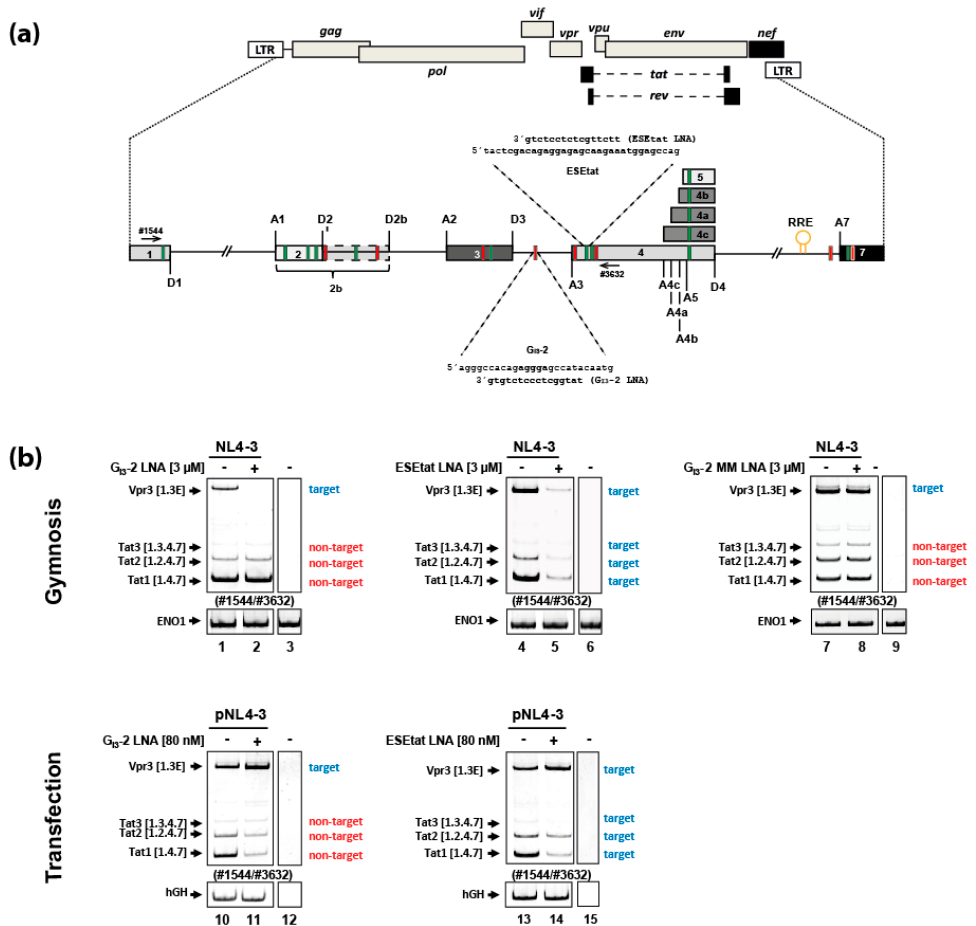
Figure 1. Gymnotically-delivered LNA mixmers targeting viral splicing regulatory elements (SREs) induce degradation of viral mRNAs containing their target sequence. ( a ) The diagram illustrates the HIV-1 proviral genome including open reading frames (ORFs) of viral proteins, long terminal repeats (LTRs), viral splice donor (D) and acceptor (A) sites as well as the viral splicing regulatory elements (enhancing SREs: Green, silencing SREs: Red). The Rev responsive element (RRE) for the Rev-dependent export of the intron-containing viral mRNA species is indicated by an open circle within the last HIV-1 intron. The primer binding sites (#1544, #3632; see Figure 1a) are also shown. The sequences as well as their target sequences of the G I3 -2 and ESE tat LNAs are indicated. ( b ) Upper panel: Jurkat cells were infected with NL4-3 (MOI: 0.005) and the LNA mixmers were gymnotically-delivered by adding them at a concentration of 3 µM to the cell culture medium 6 h post infection. Cellular ENO1 was detected to monitor RT-PCR efficiency. Lower panel: HeLa cells were co-transfected with pNL4-3 and either the G I3 -2 or ESE tat LNA mixmer. To monitor transfection and RT-PCR efficiencies, a plasmid expressing human growth hormone 1 (hGH) was co-transfected and hGH mRNA was detected using specific primers. Blue: Viral LNA target mRNAs; red: Viral LNA non-target mRNAs. HIV-1 mRNA species are indicated to the left of the gel images according to the nomenclature published previously [3]. Lanes 3, 6, 9, 12 and 15 represent mock samples running on the same gel. MM: